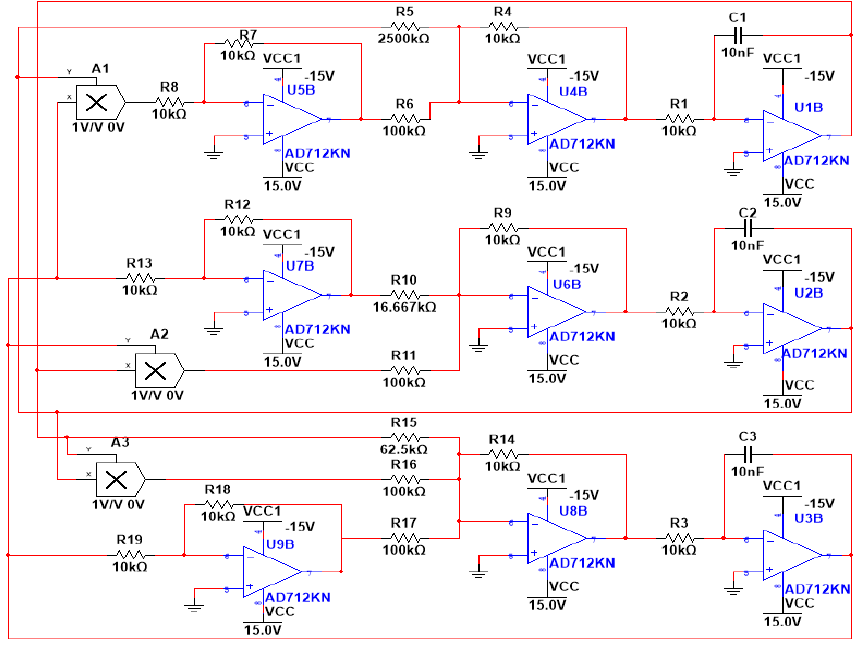
Figure 11. Electronic circuit schematics of the chaotic system